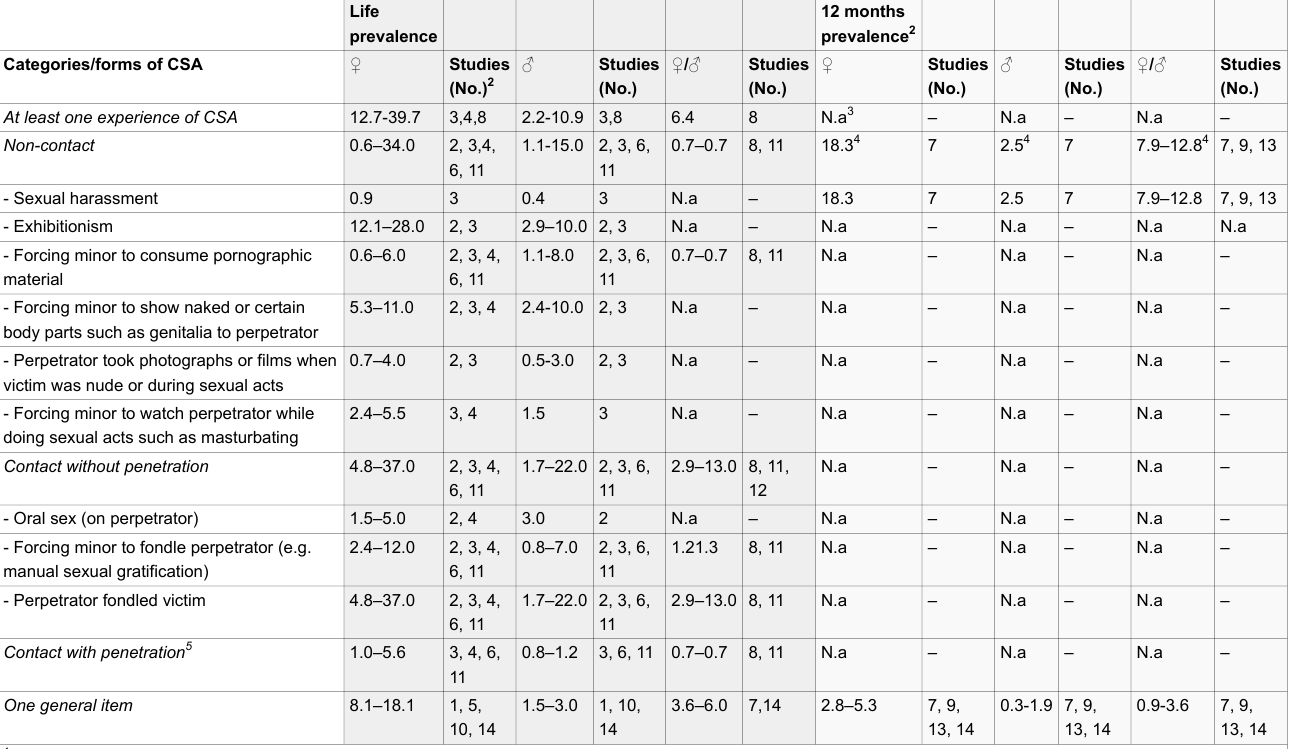
Table 2. Ranges of reported lifetime and 12-month prevalence estimates of child sexual abuse reported by Swiss studies. Life